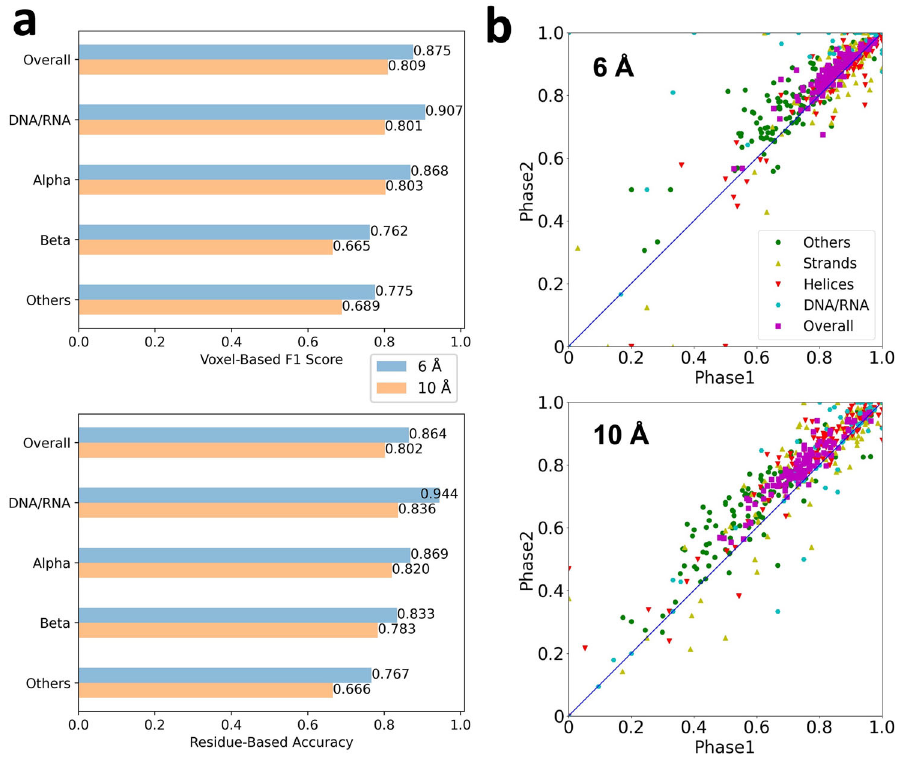
Fig. 2 The structure detection performance on the simulated map dataset. The dataset consists of 108 structures computed at two different resolutions, 6 Å and 10 Å. a Voxel-based F1 score and Q4 residue/nucleotide-based accuracy for 6 Å (blue) and 10 Å (orange) maps. b Comparison of Q4 of phase 1 and phase 2 network outputs for each of 108 test simulated maps computed at 6 Å and 10 Å. Green, other structures; yellow triangles, β strands; red triangles, α helices; cyan, DNA/RNA; magenta, overall